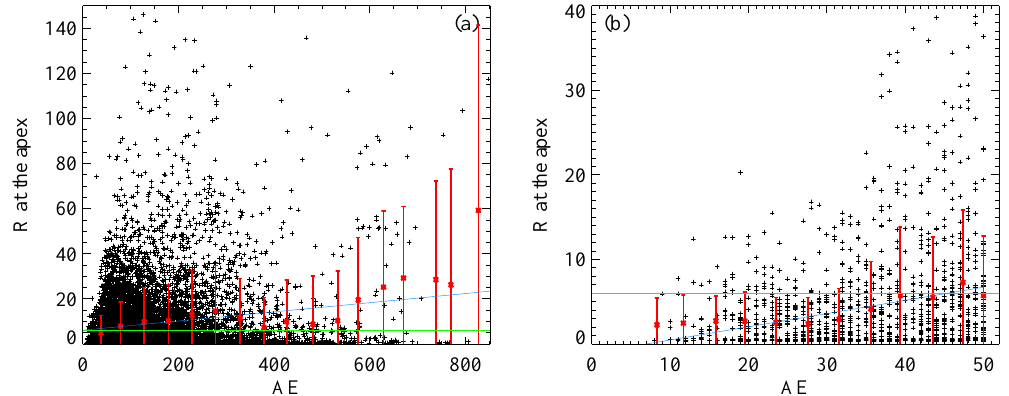
Fig. 8. Same plot as Figs. 3a, b, except the R value has been obtained using a smaller tentative fixed value of the current sheet half-thickness D (0.5 R E )